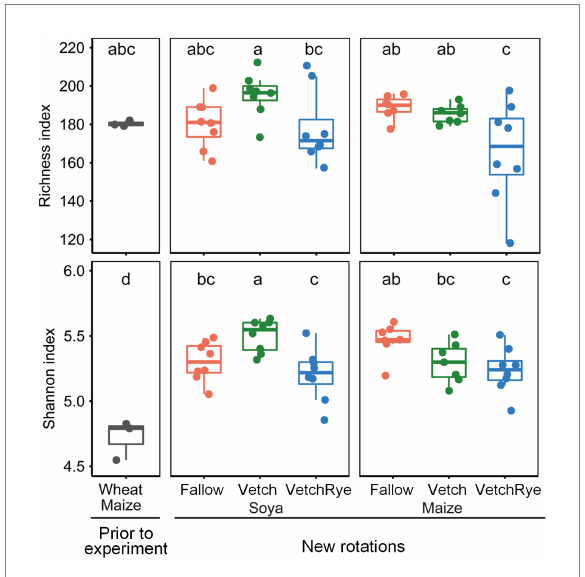
FIGURE 1 Richness and Shannon indices of the soil fungal community in the new rotation systems compared to those present prior to the experiment. Lowercase letters at the top of the boxes indicate significant differences among all cropping systems at p ≤